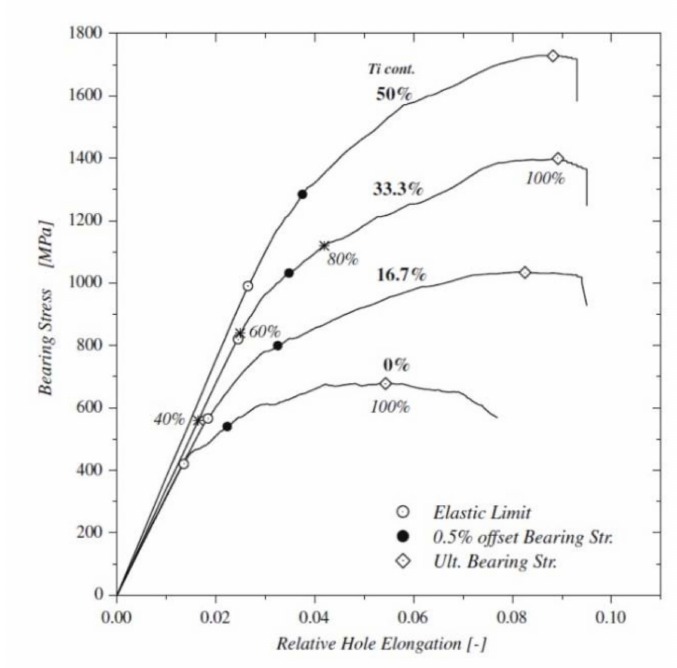
Figure 19. Strength curves of bearing tests for di ff erent contents of titanium foils in carbon / epoxy laminate